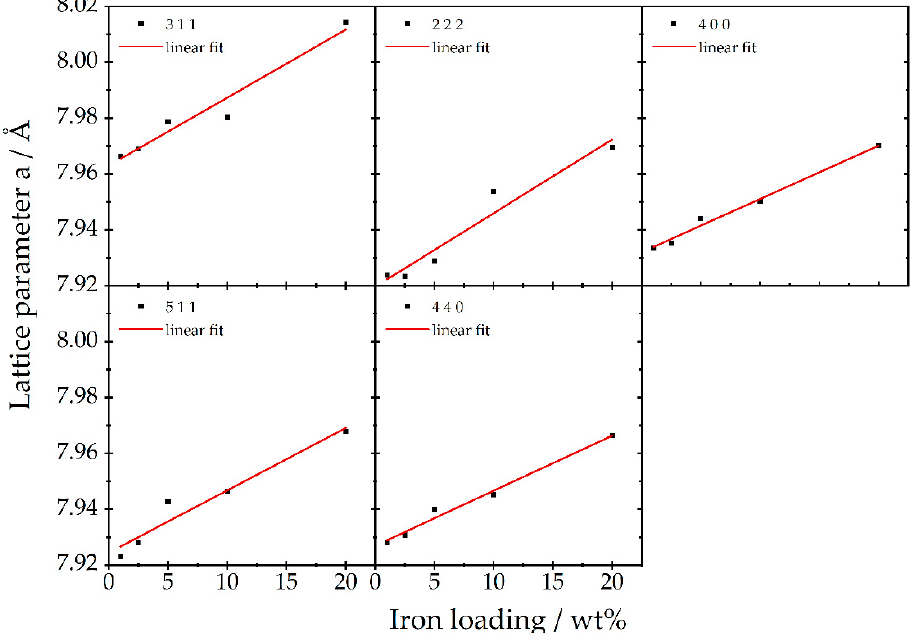
Figure 2. Cubic lattice parameter a obtained for different crystal planes of the γ -Al 2 O 3 support of Fe01 to Fe20 and the corresponding linear regression, as determined from high-resolution XRD data (beamline P24, DESY).